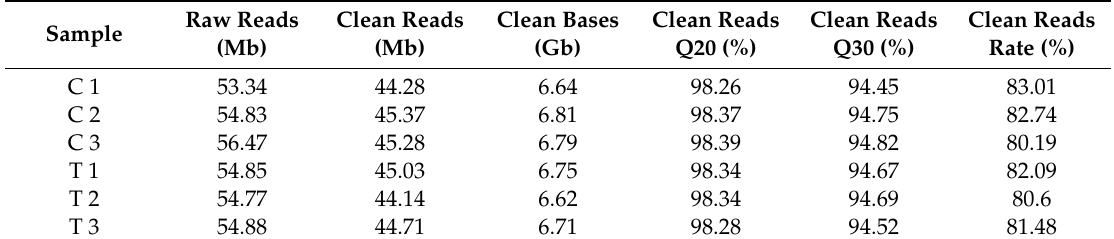
Table 1. Summary of sequence reads for six RNA samples including three replicate control treatments (C1–C3) and three samples of cadmium treatment (T1–T3).